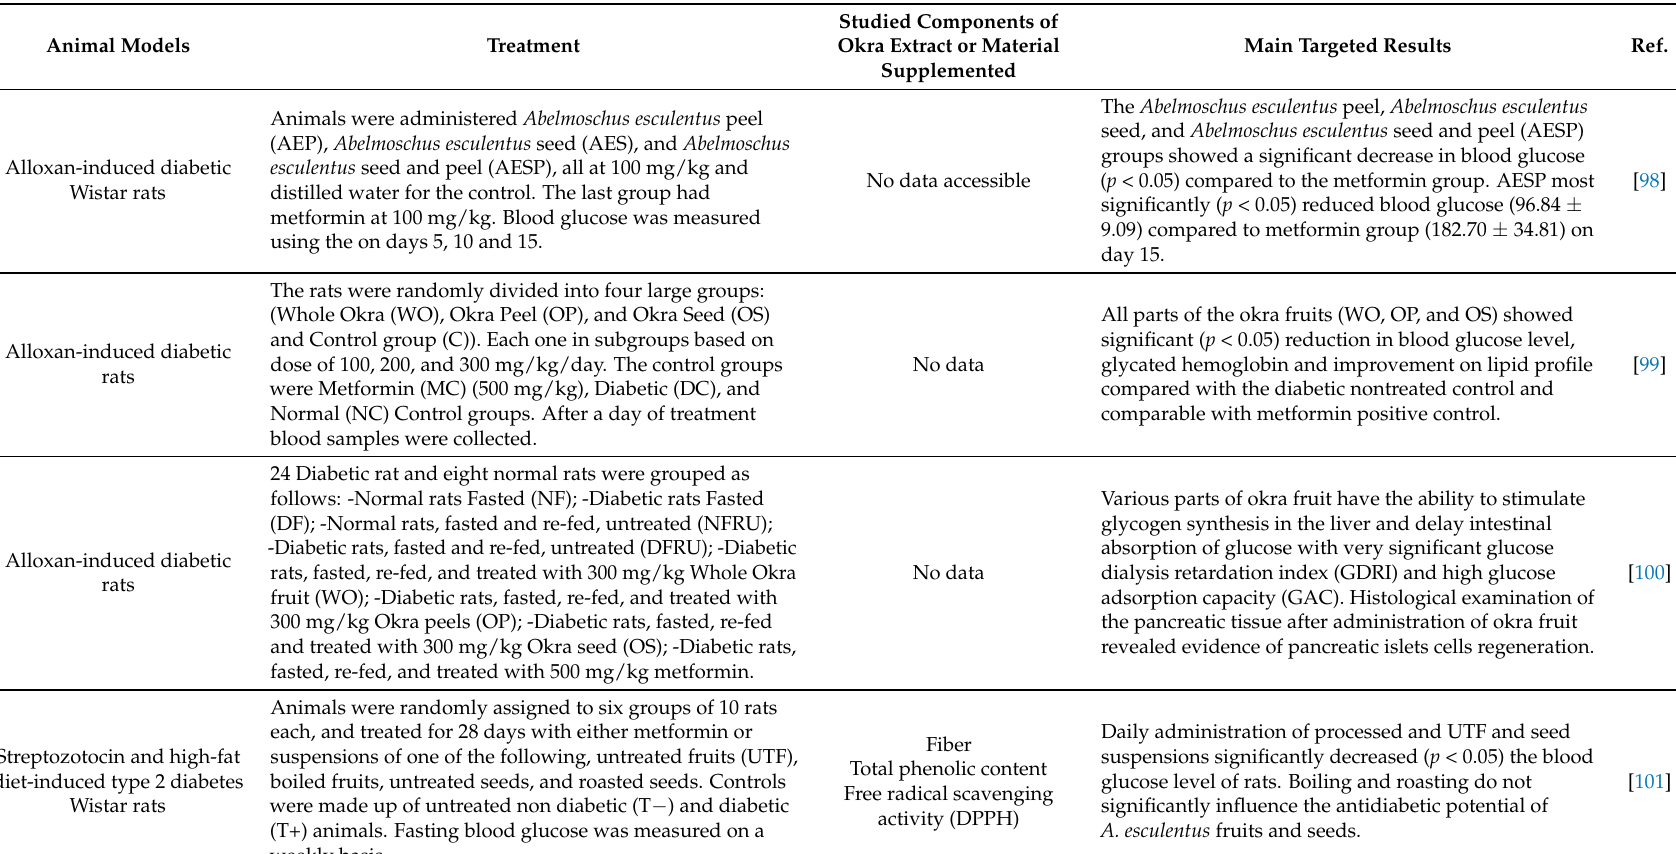
Table 1. Some examples of current researches in potential antidiabetic in animal